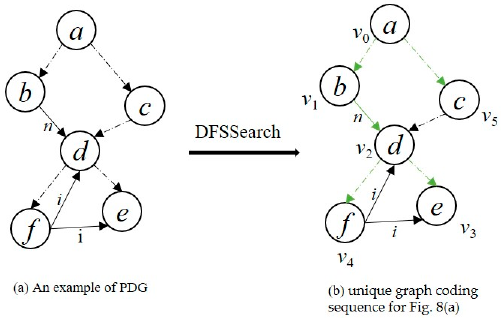
Figure 8. PDG2Seq algorithm example. Table 2. Graph code sequence.